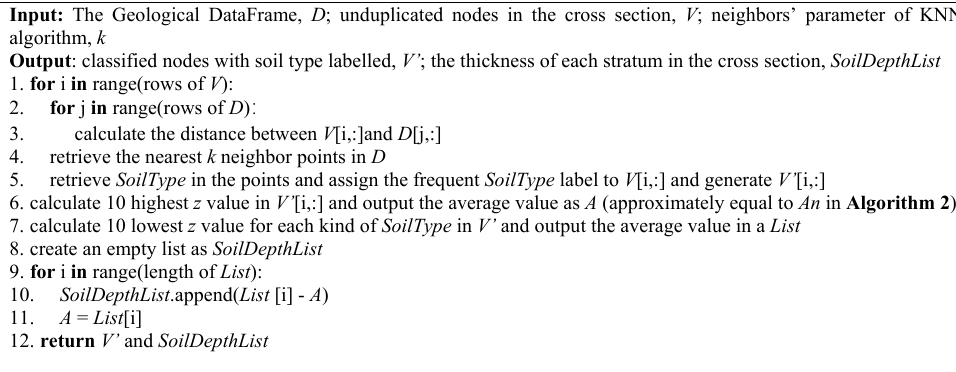
Algorithm 3 . Stratum sequence identification and thickness